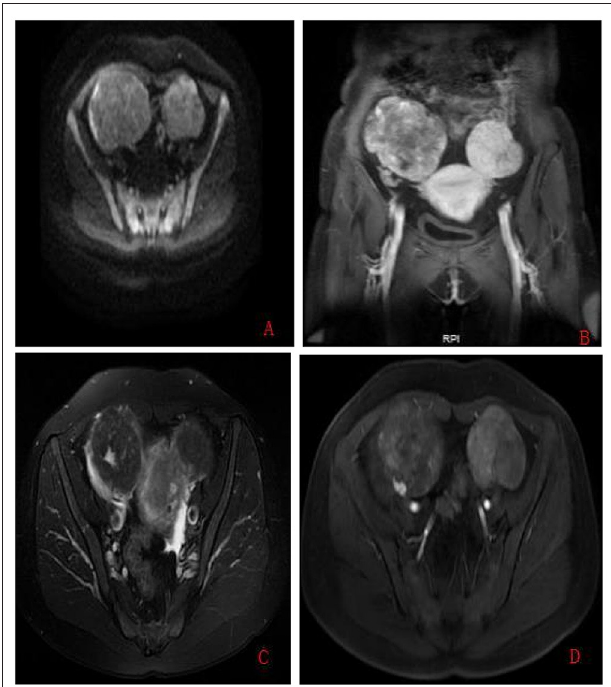
FIGURE 1 | Preoperative pelvic MRI findings obtained for case 8. (A) On axial diffusion-weighted image (repetition time (TR)/echo time (TE): 4,000/72.4ms, b -value = 500 s/mm 2 ); the two masses showed the same intermediate signal intensity. (B) On sagittal T1-weighted with gadolinium administration (TR/TE: 3.9/1.7ms), the left mass showed low signal intensity identical to the uterus myometrium. (C) On axial fat-saturated T2-weighted (TR/TE: 3,020/70.5ms) image, the signal intensity of the left mass was continuous with the myometrium, while the right mass was well-circumscribed and sharply demarcated from the uterus. (D) On axial T1-weighted with gadolinium administration (TR/TE: 3.9/1.7ms), flow voids were visible only between the tumor and the uterus myometrium on the left